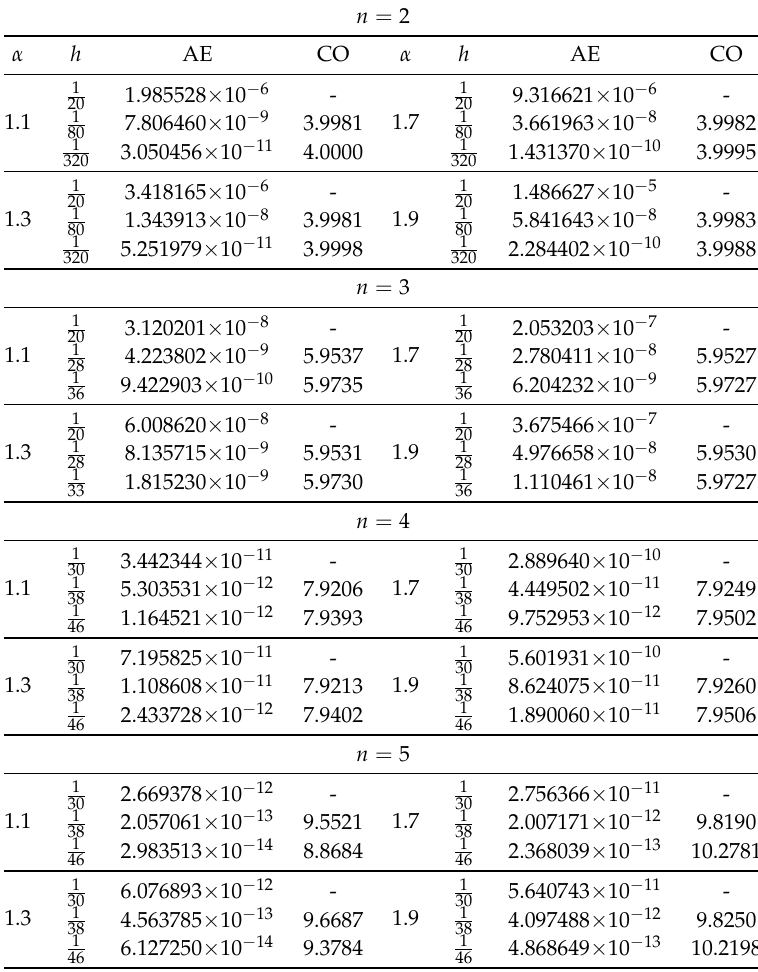
Table 12. The absolute error and the experimental convergence order of function f 2 ( x ) in Example 12 by numerical scheme (281) with n =